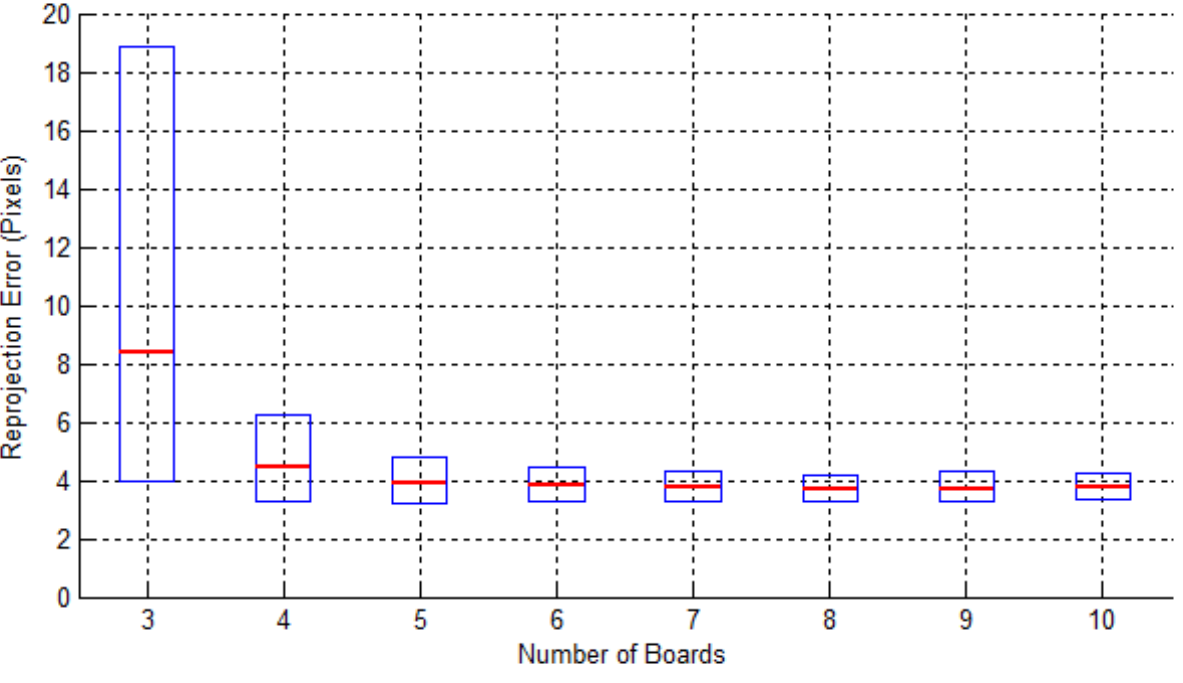
Figure 15. Box-plots of reprojection (pixel) errors for different numbers and positions of the diamond board. The red line in the boxes represents the average error and the extents of the boxes are at 25th and 75th